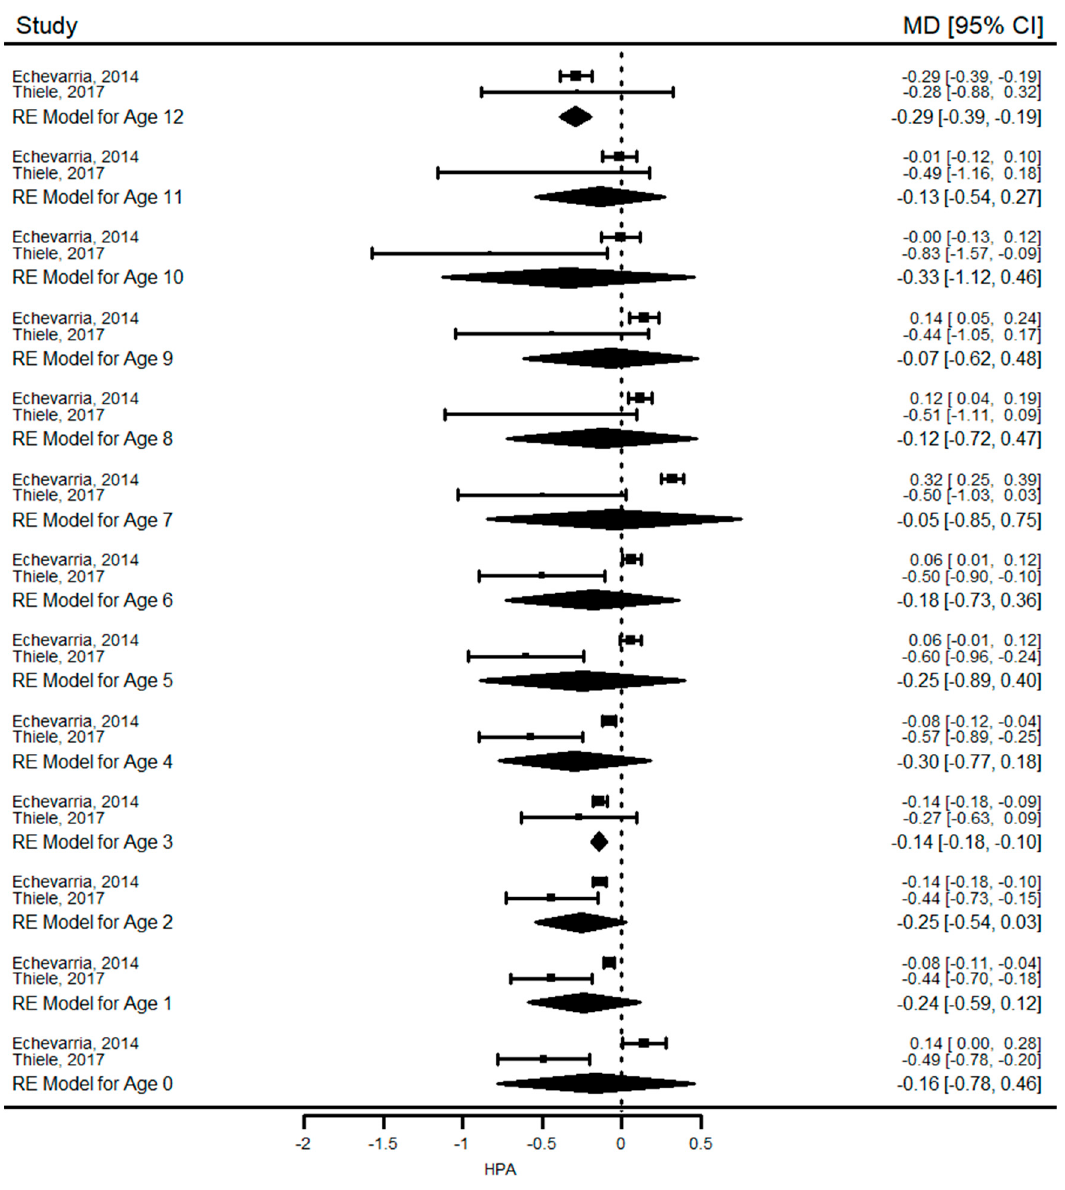
Figure 3. Comparison of mean difference height-for-age z-scores of patients with mHPA compared to healthy population from birth to 12 years of age. Abbreviations: HPA: mild-hyperphenylalaninemia; RE: Random effect; MD: Mean difference; CI: Confidence interval.